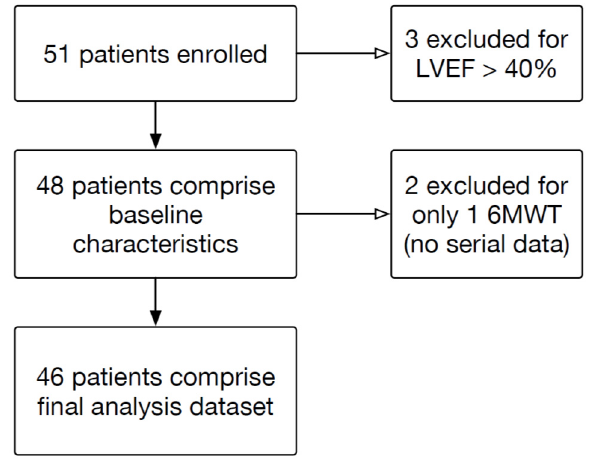
Figure 1. Enrollment and patient flow through the study.